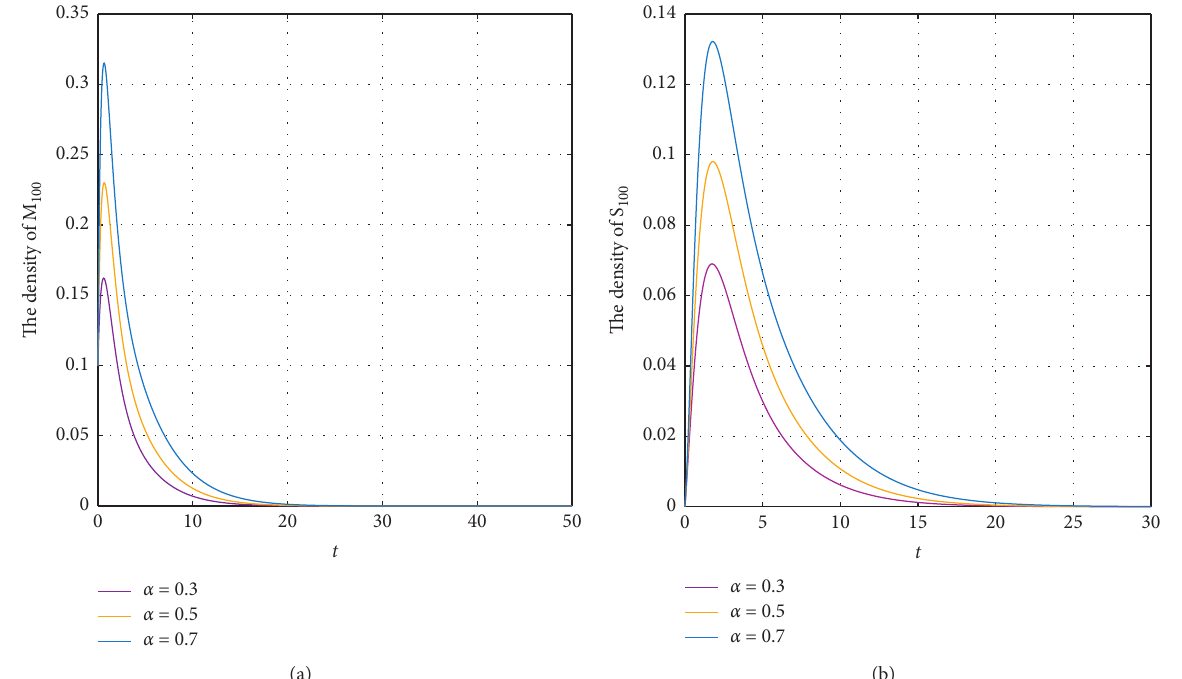
Figure 5: The prevalence of M